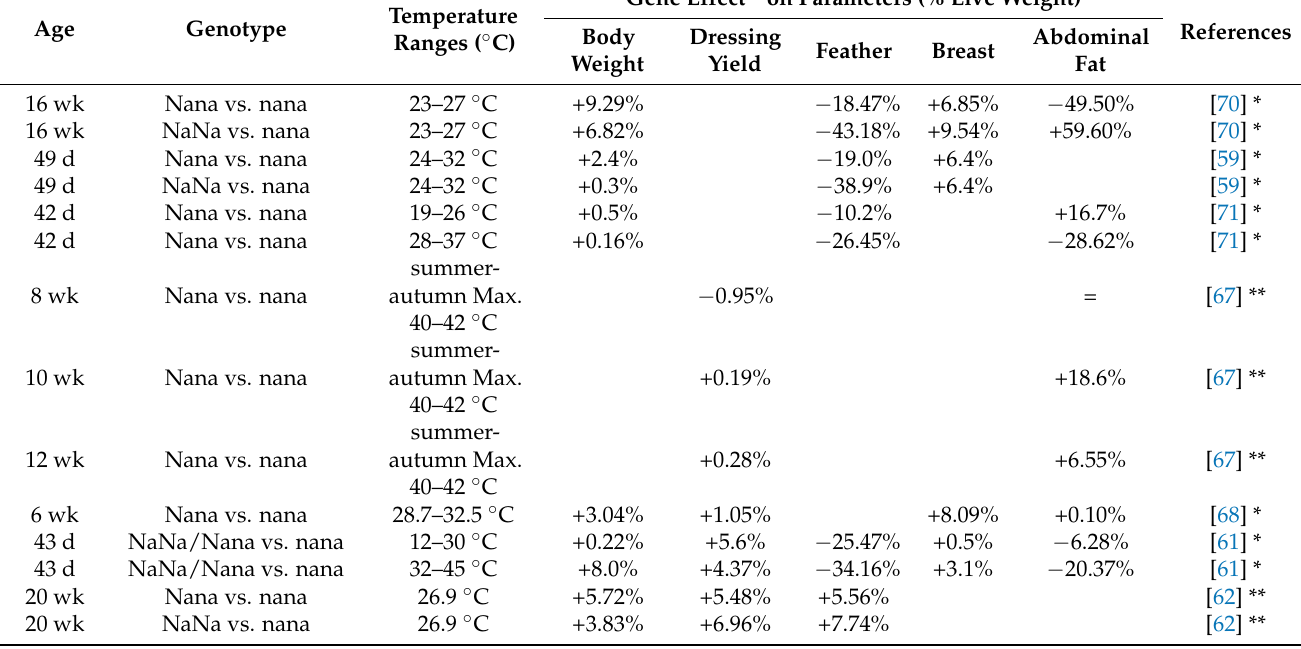
Table 2. Results from different studies on the effect of Na gene (% live weight) on different strains at different ages and temperatures on body weight, dressing yield, feather weight, breast, and abdominal fat